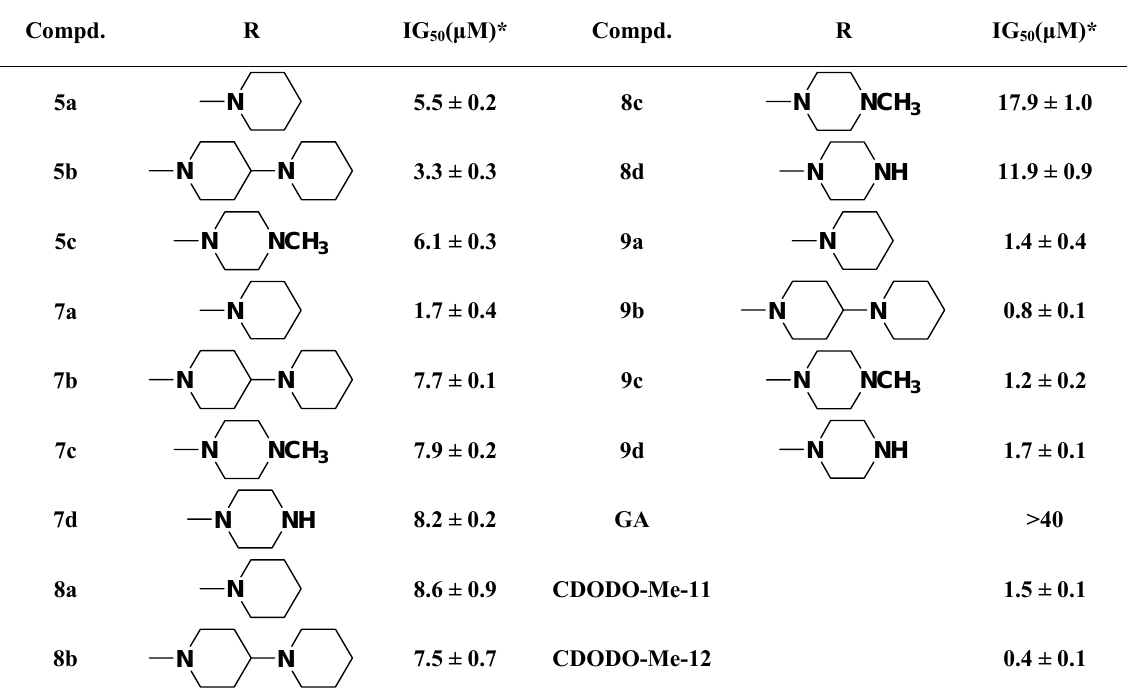
Table 1. The antiproliferative activities of target compounds in HL-60 cells. R IG 50 ( μ M)*